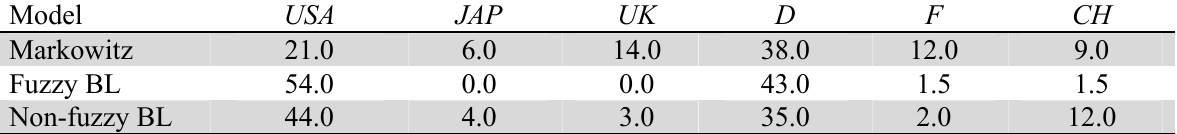
Optimized portfolio weights based on the in-the-sample period (Jan 2003 to August 2009) referring to different optimization models in %